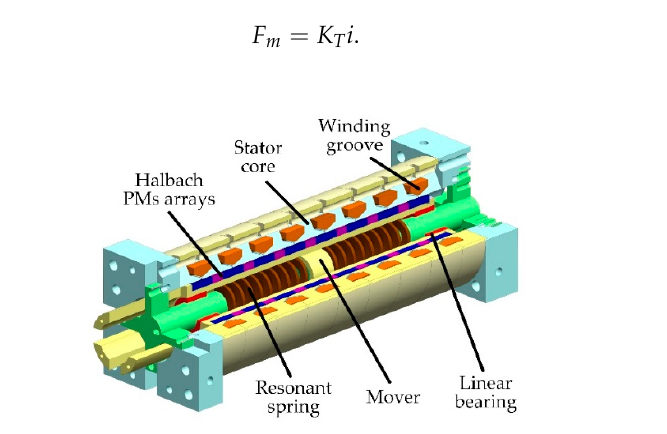
Figure 6. Employed linear oscillating motor [24].